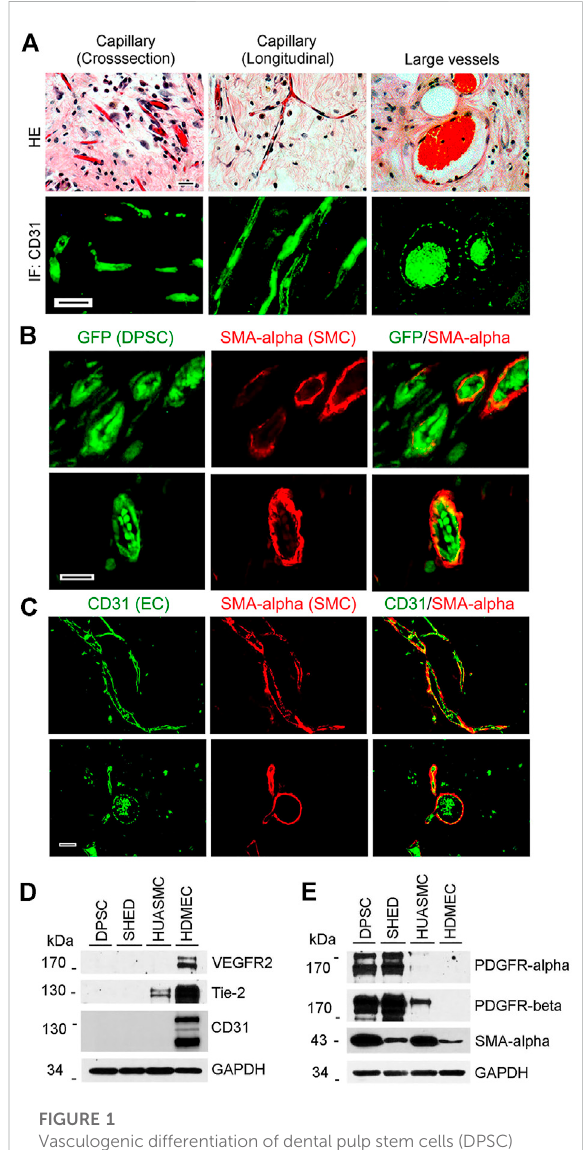
FIGURE 1 Vasculogenic differentiation of dental pulp stem cells (DPSC) in vivo . 1000000 GFP-transduced DPSC cells were seeded in scaffolds and transplanted into the subcutaneous space of the dorsum of SCID mice for 4 weeks. Scaffolds were retrieved and fi xed with 10% buffered formaldehyde for HE and immuno fl uorescence staining. (A) HE staining showed capillaries and large blood vessels. DPSC-derived endothelial cells were positively stained with CD31. (B) Endothelial cells lining blood vessels were positive for GFP (i.e., generated upon vasculogenic differentiation of DPSC-GFP cells) while mural cells (pericytes/ SMC) were positive for SMA- α , but not GFP (i.e., mural cells were recruited form the mouse host). (C) Immuno fl uorescence showing that endothelial cells were stained with CD31 while mural cells with SMA- α . Scale bar: 50 µm. (D,E) Western blots from cells (DPSC, SHED, HUASMC, and HDMEC) cultured in α -MEM supplemented with 5%FBS for the endothelial cell markers VEGFR2, Tie-2 and CD31 (D) , and for mural cell markers PDGFR- β and SMA- α (E) . HDMEC cells were used as positive control for endothelial cells, and HUASMC as controls for mural cells. GAPDH was used as loading